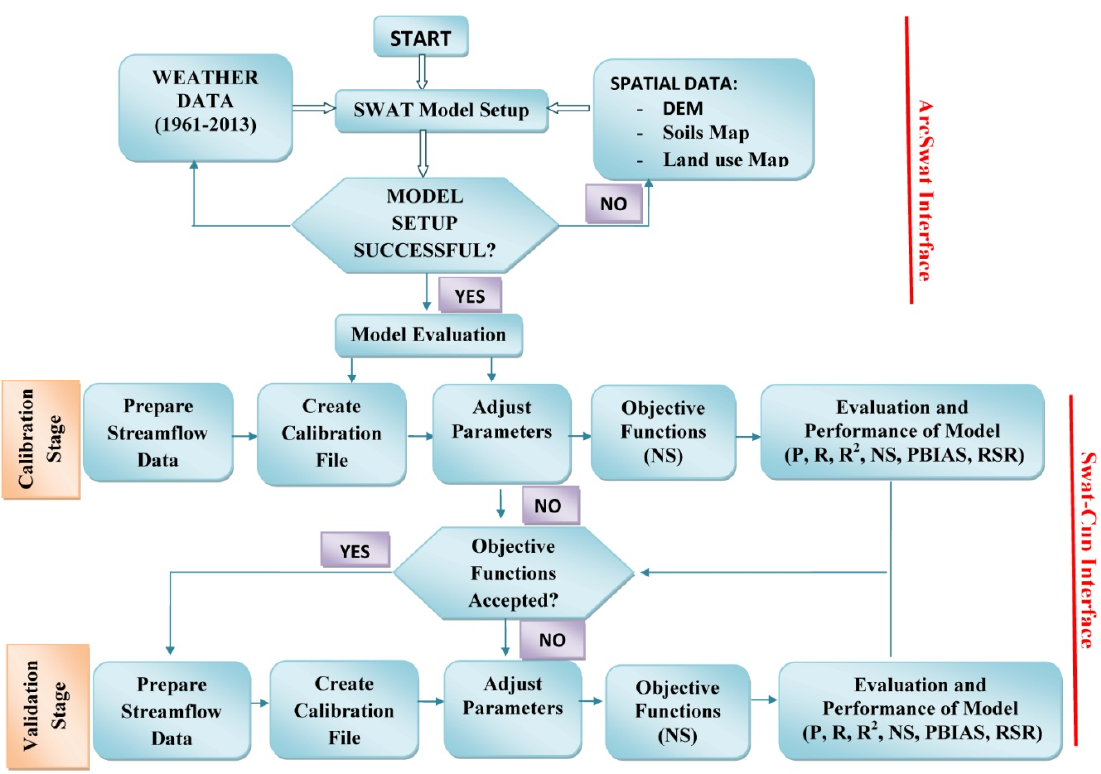
Figure 2. Diagram of SWAT model [48].